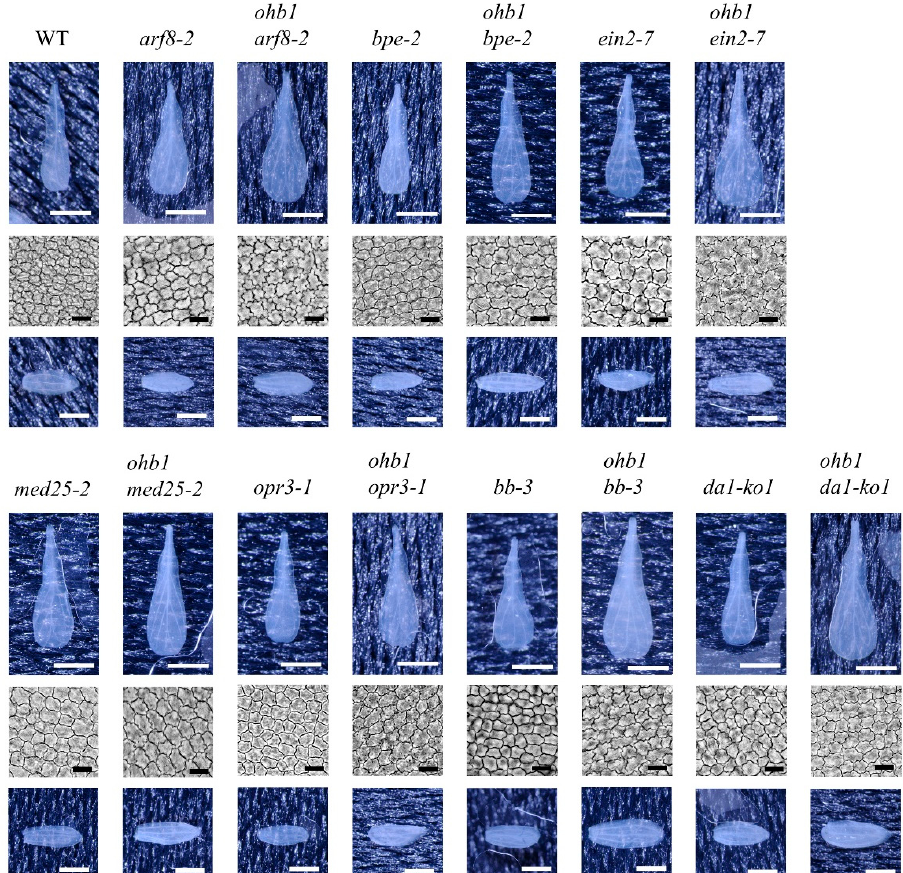
Figure 3. Phenotypic characteristics of flowers produced by previously identified large flower mutants and double mutants that had been created through a cross with the ohb1 mutant. Petals, petal abaxial epidermal cells, and the sepals in each line are shown. White and black bars represent 1 mm and 20 µ m, respectively.